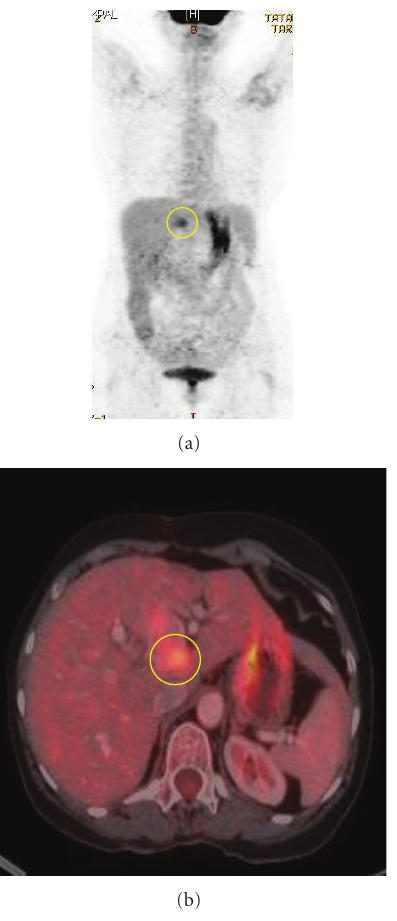
Figure 7: PET Scan (a) and Octreotride labelled (b) scan showing tumor limited to the hepatobiliary system.